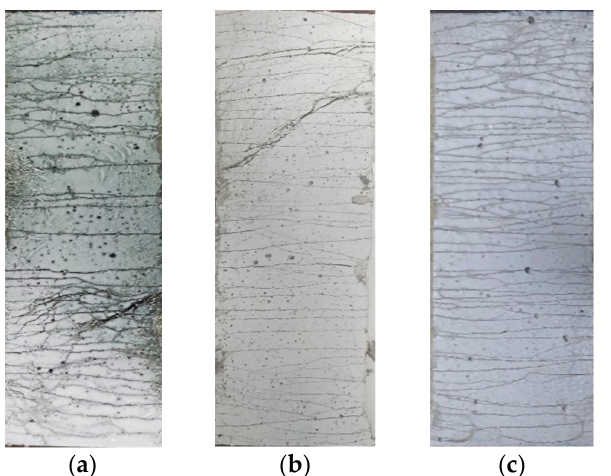
Figure 13. Crack patterns of the three types of ECC after the rupture of the specimen: ( a ) ECC-PC; ( b ) ECC-LC 3 –35; ( c ) ECC-LC 3 –50. Table 7. Cracking characteristics.